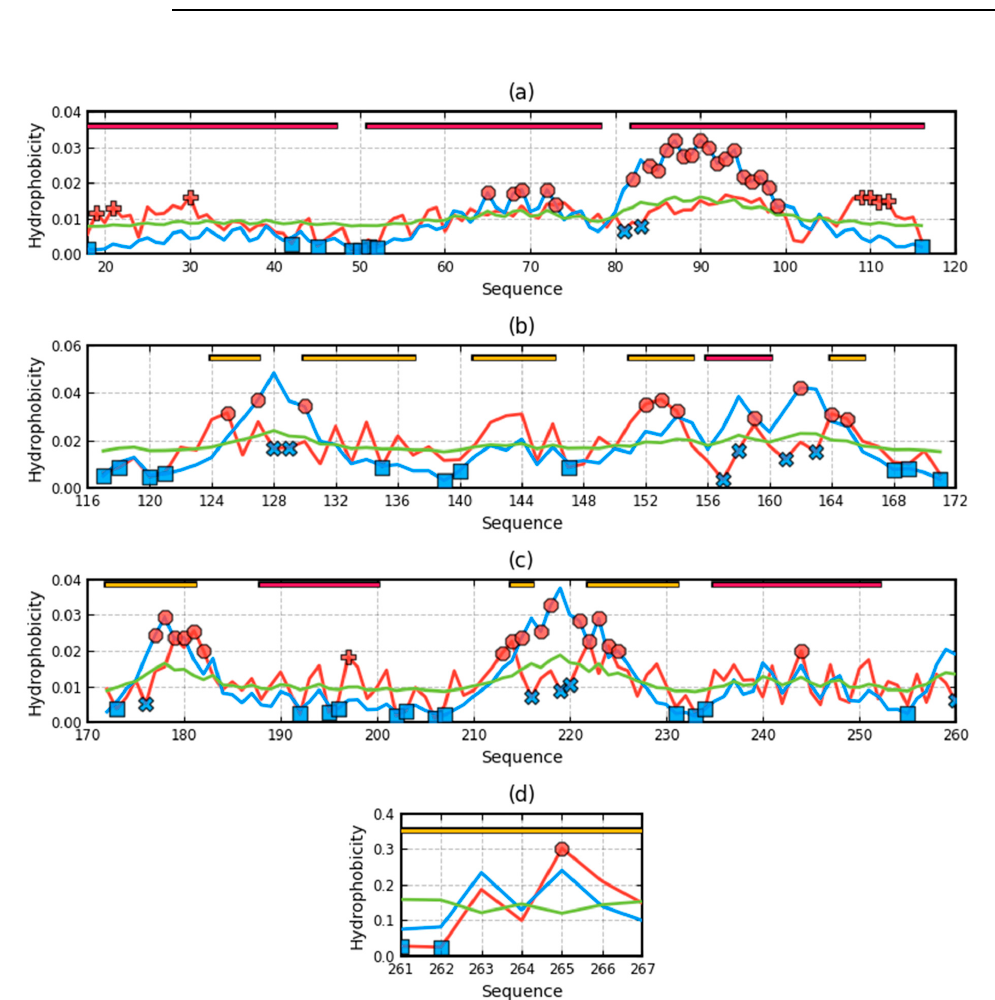
Figure 9. Profiles T, O, and M in 4HW9-3D Gauss function generated for the complex. ( a )—dom1, ( b )—dom2, ( c )—dom3, ( d )—dom4—beta-barrel. T distribution—blue, O distribution—red, M distribution—green. Top bars: yellow—beta-structure, yellow—helix. Red circles—residues potentially engaged in hydrophobic core construction, blue “X”—residues of hydrophobicity deficiency—here residues engaged in channel construction, red “+”—hydrophobicity excess potentially engaged in protein–protein complexation—here—the interaction with membrane. The blue squares—residues on the surface representing low hydrophobicity—a status accordant with FOD criteria.